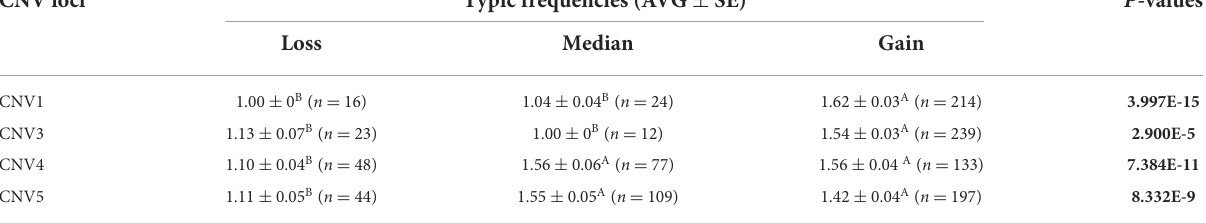
TABLE 5 Association analyses between litter size and copy number variation types in SBWC